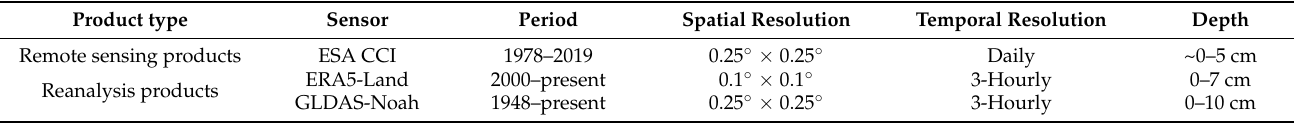
Table 2. Information on SM products.